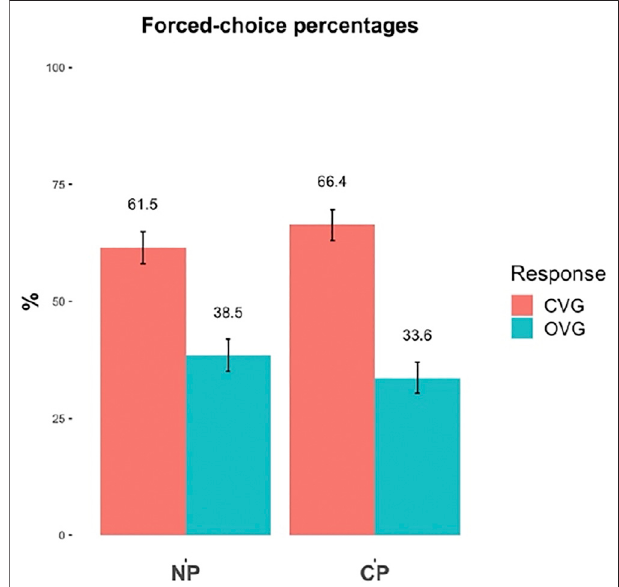
FIGURE5| Eachbarshowsthepercentageofchoosinganoption(CVG or OVG) across the two conditions, NP and CP (the con fi dence intervals are calculated using prop.test() function in R).